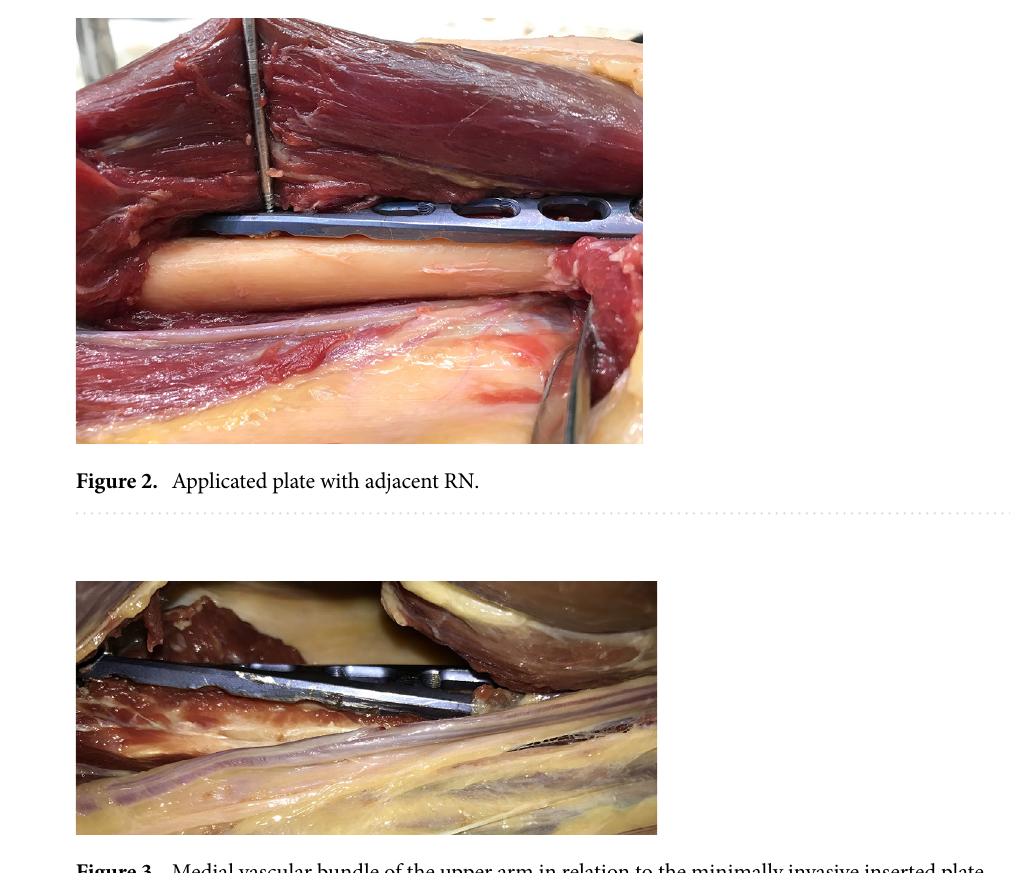
Figure 3. Medial vascular bundle of the upper arm in relation to the minimally invasive inserted